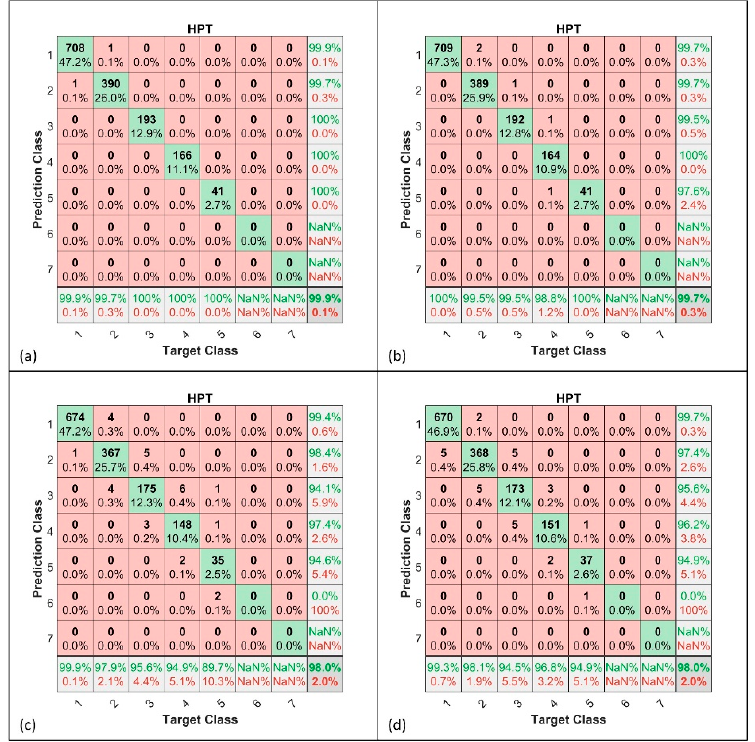
Figure 12. Confusion matrix for HPT. ( a ): Single-component FFNN; ( b ): single-component KPCA + FFNN; ( c ): multi-component FFNN; ( d ): multi-component KPCA + FFNN.